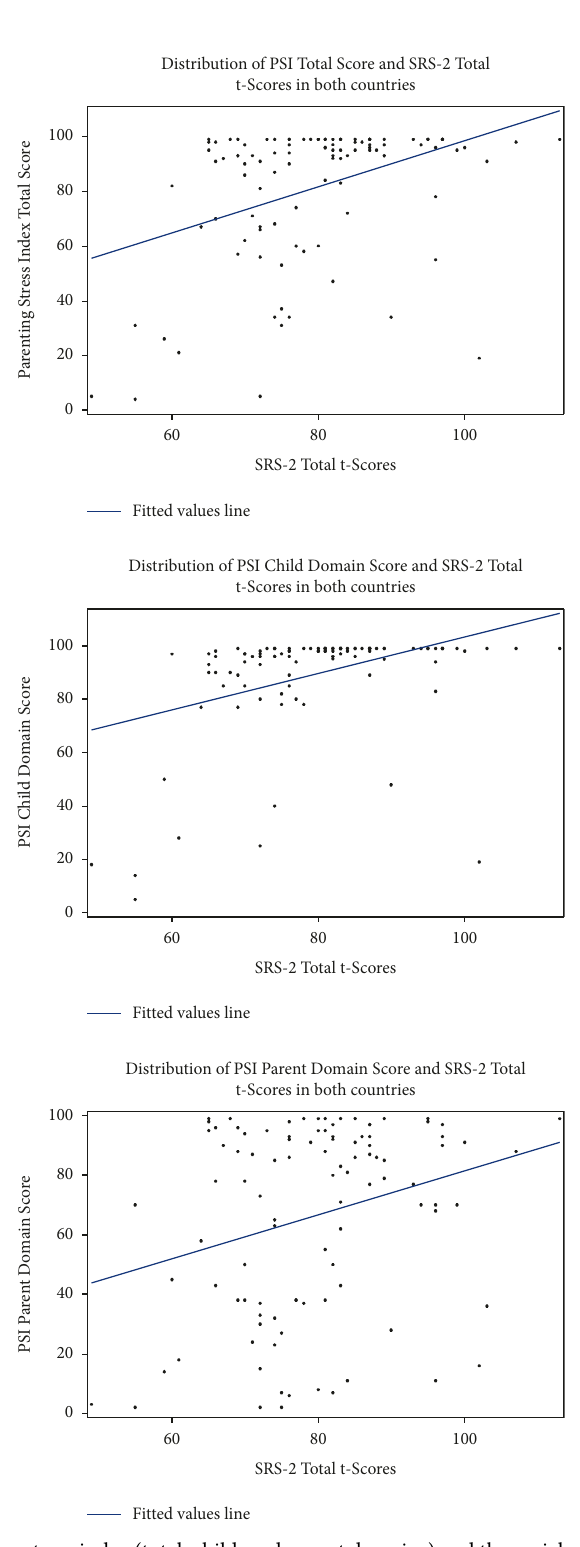
Figure 2: Distribution of the parenting stress index (total, child, and parent domains) and the social responsiveness scale-2 total t-scores in combined U.S. and Japan